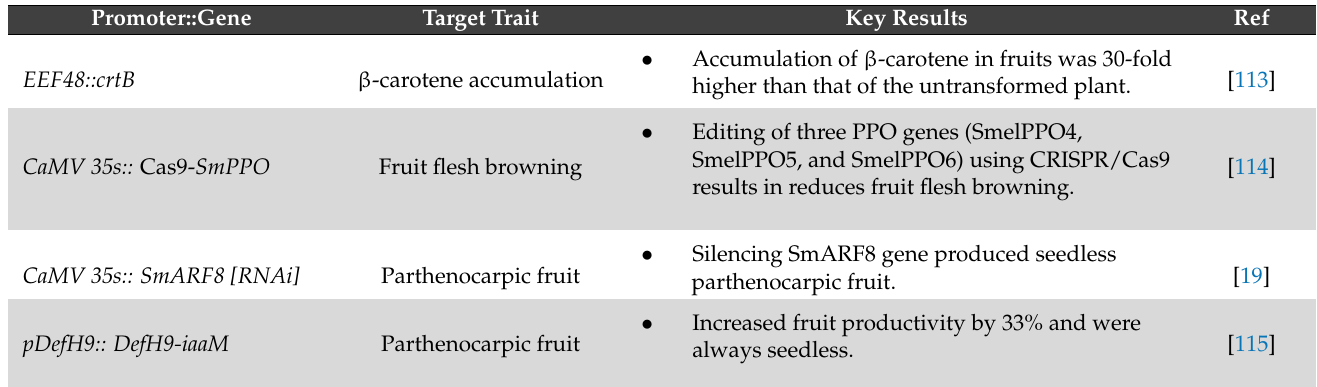
Table 6. Transgenic eggplant resistant for productivity and